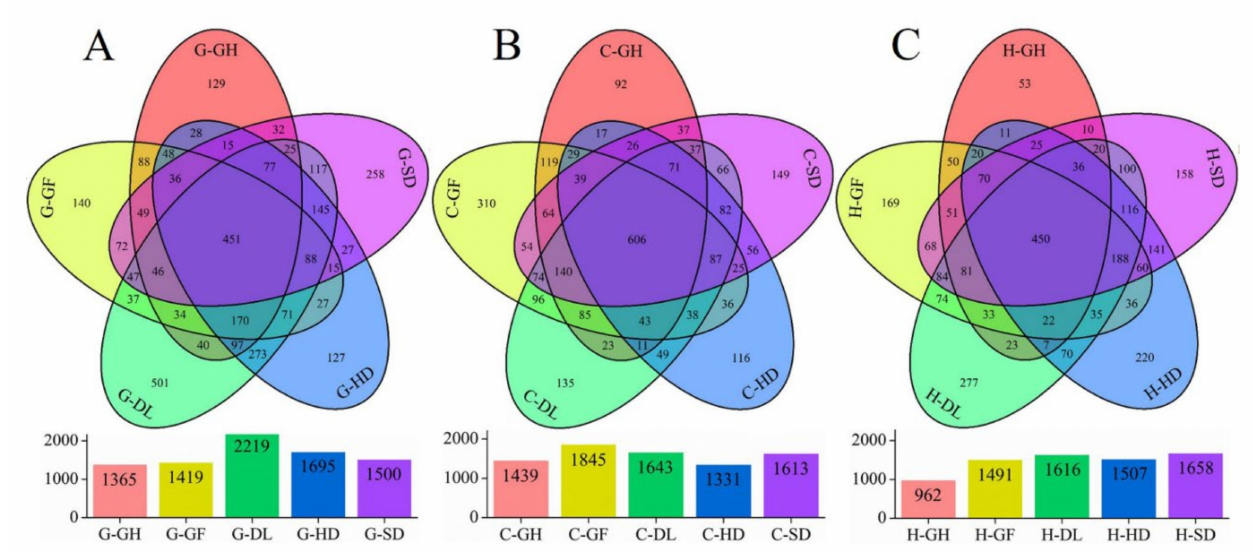
Figure 4. Variation-partitioning analysis for explaining soil bacterial diversity by different habitat across three sites sampled from cold-desert, Qinghai–Tibet Plateau, China: which was shown in a five-way Venn diagram. The shared and unique OTU found in each site and habitat are represented by different circles and clusters per segment. ( A ) GEM site; The number of OTU (451) was shared by all of the bacteria with each site; ( B ) CNH site; shared OTU (606); ( C ) HLH site; shared OTU (450), respectively. CNH—CuoNaHu, HLH—HongLiangHe,